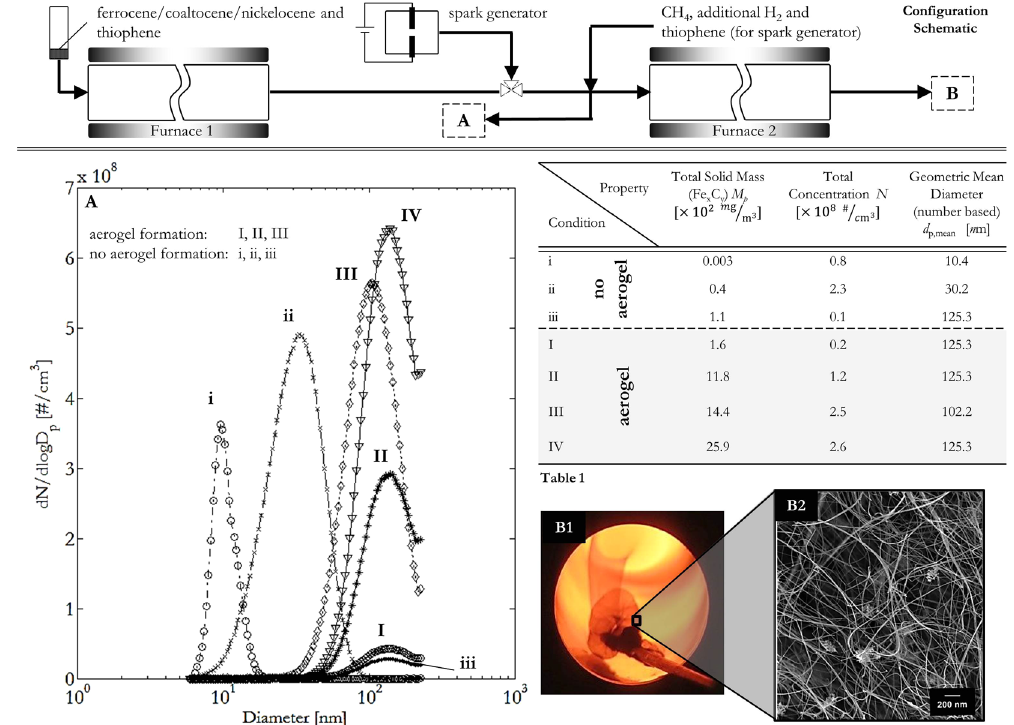
Figure 3. Configuration Schematic (top) Experimental setup for a decoupled CNT aerogel process, measuring the formed nanoparticles after Furnace 1 and collecting CNT material at the outlet of Furnace 2. The temperature set-point of Furnace 1 is varied as described in the Methods, Furnace 2 is set to 1290 °C, a more detailed schematic can be found in the supplementary information (S6). ( A ) Particle size distributions measured at the outlet of Furnace 1 for different temperature set points where ( I – IV ) lead to CNT aerogel formation and ( i – iii ) do not. Further characterization of the nanoparticles entering Furnace 2 is supplied in Table 1. ( B1 , B2 ) Photograph and SEM of a representative CNT aerogel sample taken at the outlet of Furnace 2, feeding in nanoparticles with a mean diameter d p,mean > 100 nm (size distributions ( I – IV )). The aerogel shows CNTs and CNT-bundles of diameter ~8–40 nm with occasional encapsulated-catalyst and carbonaceous